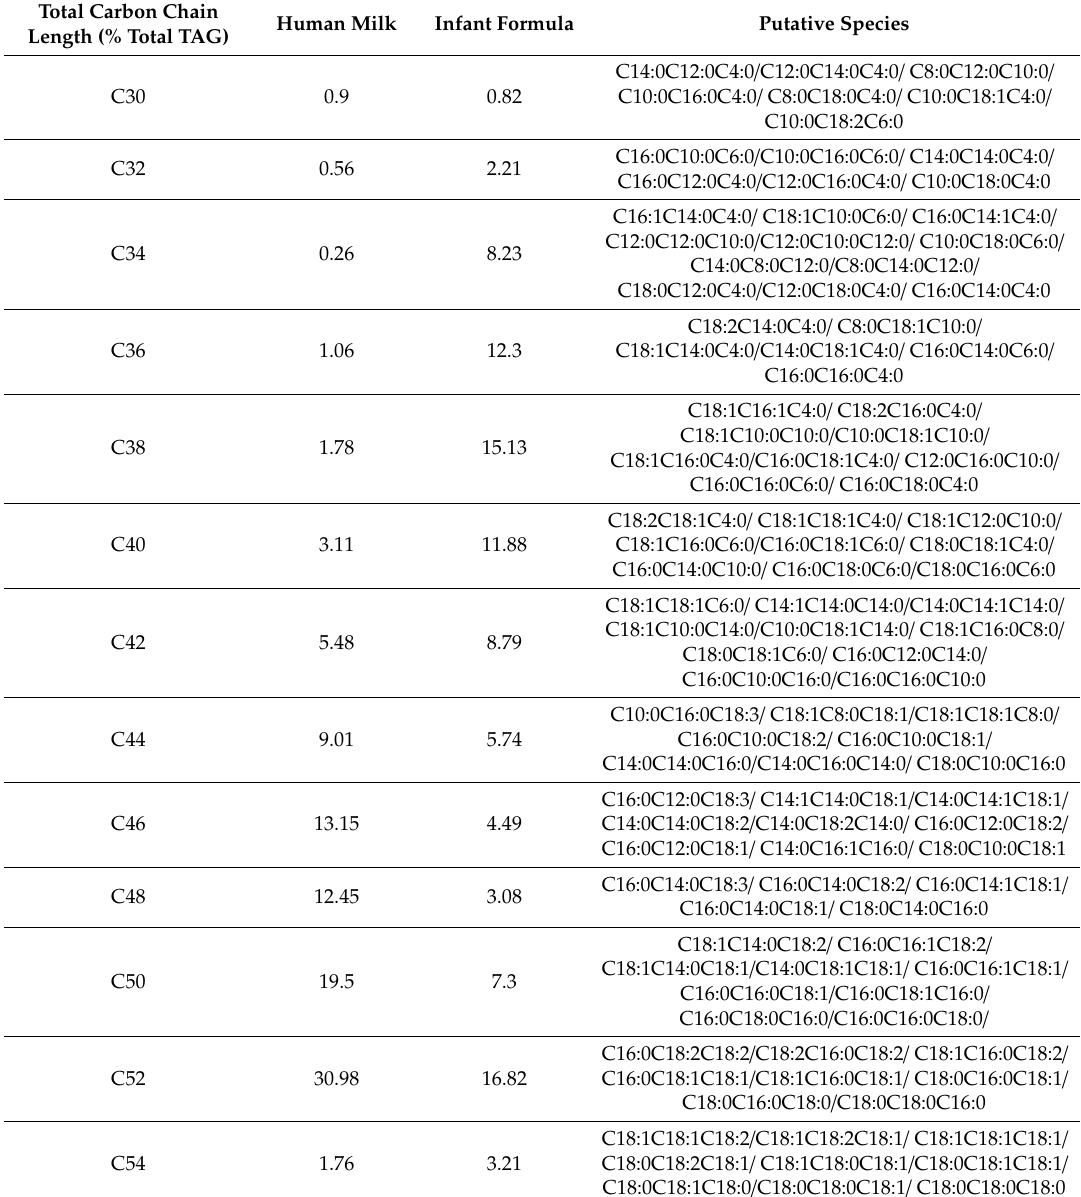
Table 2. Triacylglycerol (TAG) profile of human milk and infant formula samples Total Carbon Chain Length (% Total